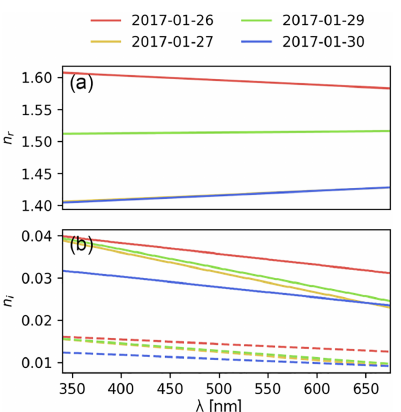
Figure 9. Retrieved complex refractive index for each case: (a) n r and (b) n i . The dashed line in panel (b) is the wavelength-dependent n i measured by AERONET.